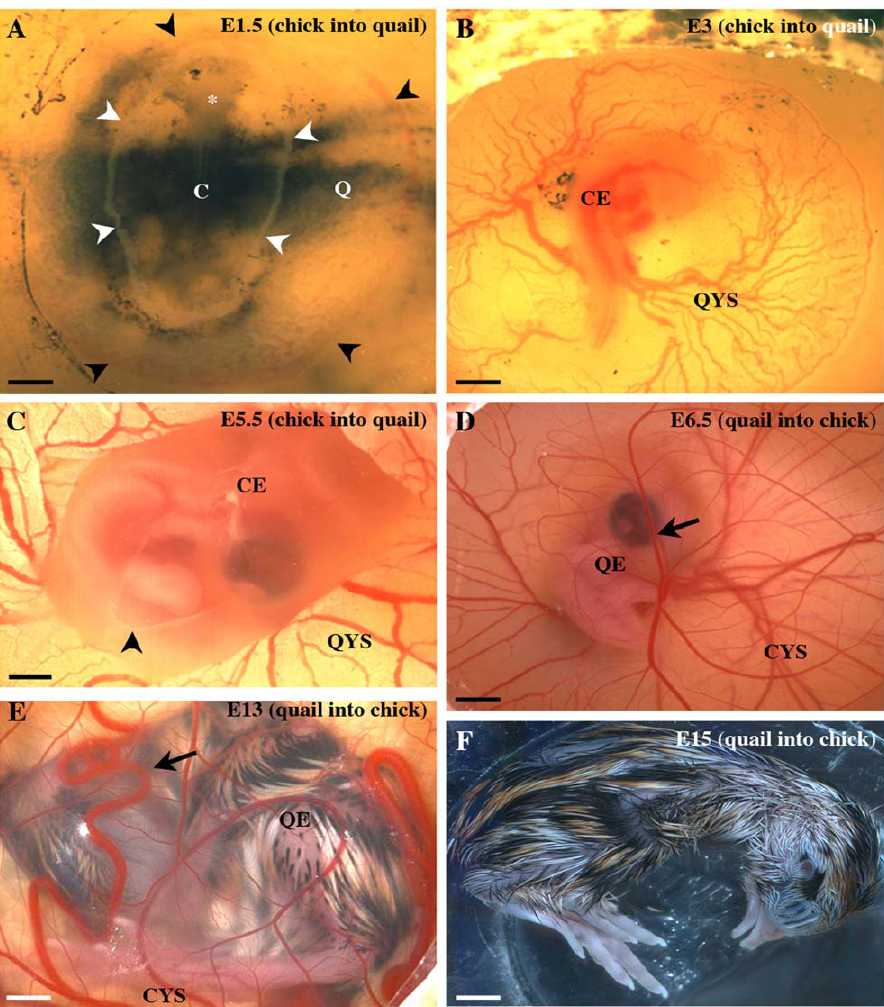
Figure 1. Generation of yolk sac chimeras. A–C) chick embryos on quail yolk sacs; A) A yolk sac chimera just after the operation: in this case, a 10 somite old chick embryo (C) is grafted on a quail yolk sac recipient at the same stage (Q). The black arrowheads show the sinus marginalis, the limit of the quail vascular area. The white arrowheads point to the suture between the chick and quail territories. The asterisk marks the chick head. Bar: 1 mm. B) A yolk sac chimera two days after the operation: in the quail egg a chick embryo (CE) correctly develops and vascular connections with the quail yolk sac (QYS) are normal. Bar: 2 mm. C) A chimera after four days, with a healthy E5.5 chick embryo (CE), wrapped in the amnion (arrowhead) and connected to a quail yolk sac (QYS). Bar: 1.5 mm. D–F) quail embryos on chick yolk sacs; D) After 5 days the quail embryo (QE) developed